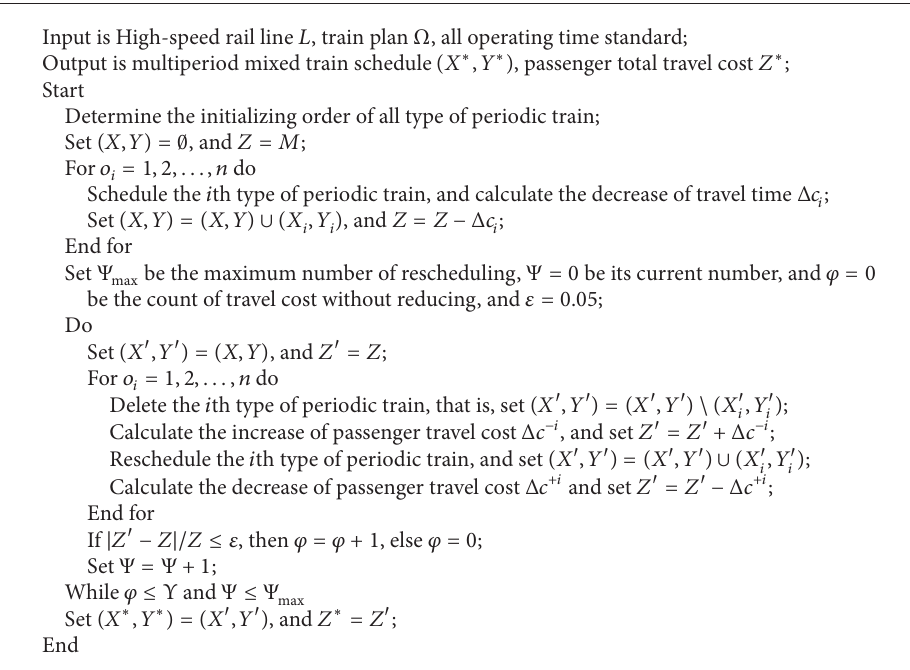
Algorithm 3: Optimizing the multiperiod mixed train schedule of high-speed railway.